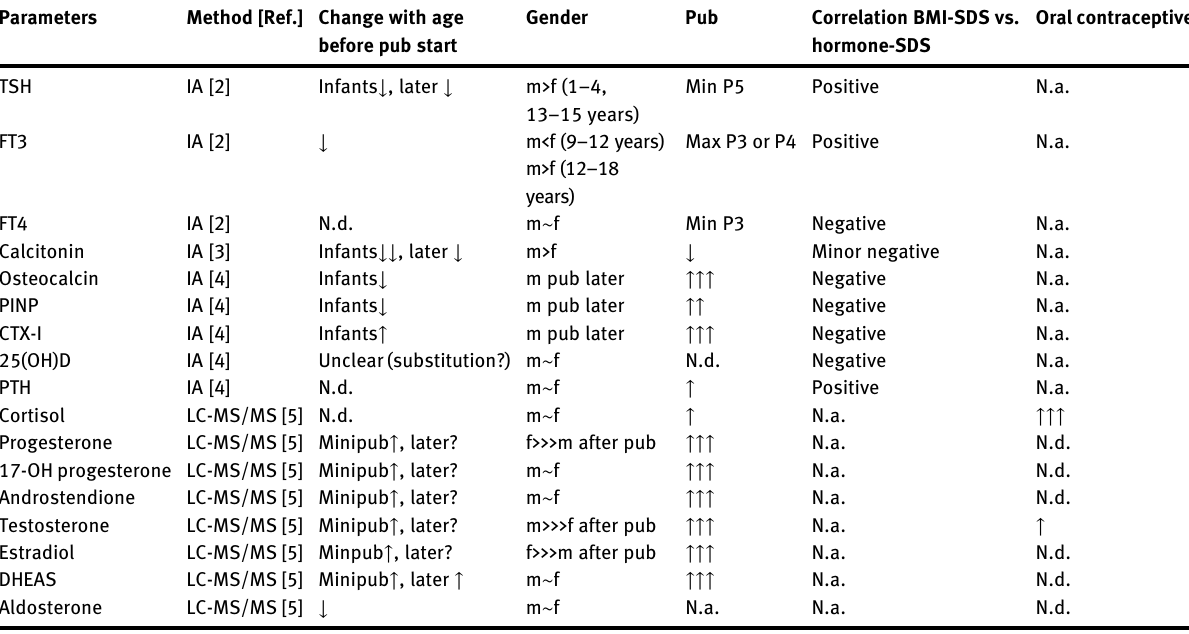
Table  : Overview of the effect of age before puberty, gender, puberty, body mass index standard deviation score (BMI-SDS), and the use of contraceptives on reference intervals for 